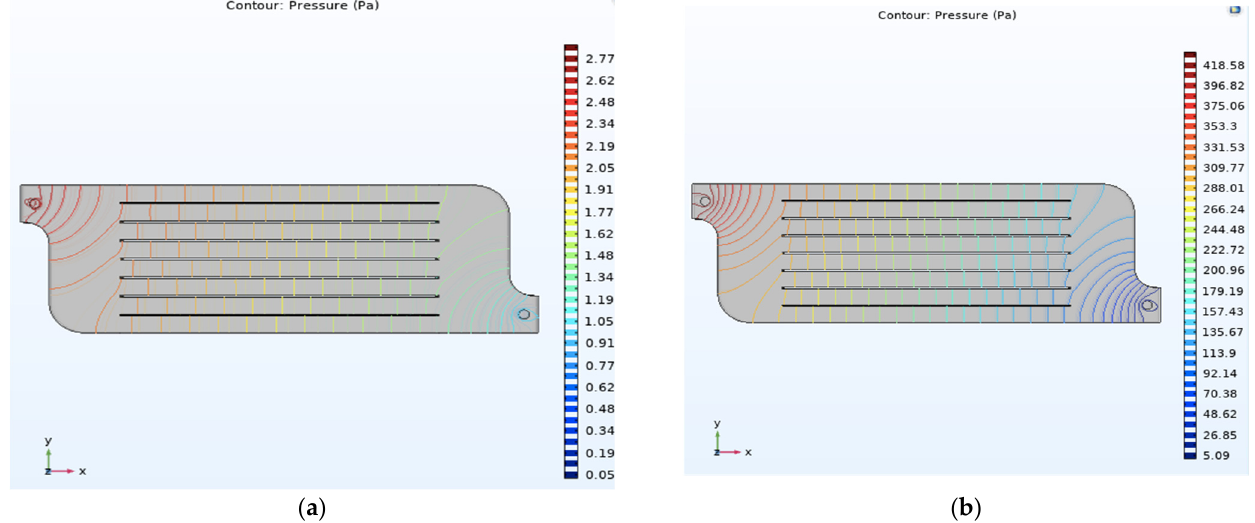
Figure 7. ( a ) Pressure profile of the numbering ‐ up microreactor at inlet gas flow rate Y g = 274.8 mL/min Re = 76.32 and P 0 = 1 atm, ( b ) Pressure profile of the numbering ‐ up microreactor at inlet liquid flow rate Y l = 8.48 mL/min, Re = 19.54 and P 0 = 1 atm.